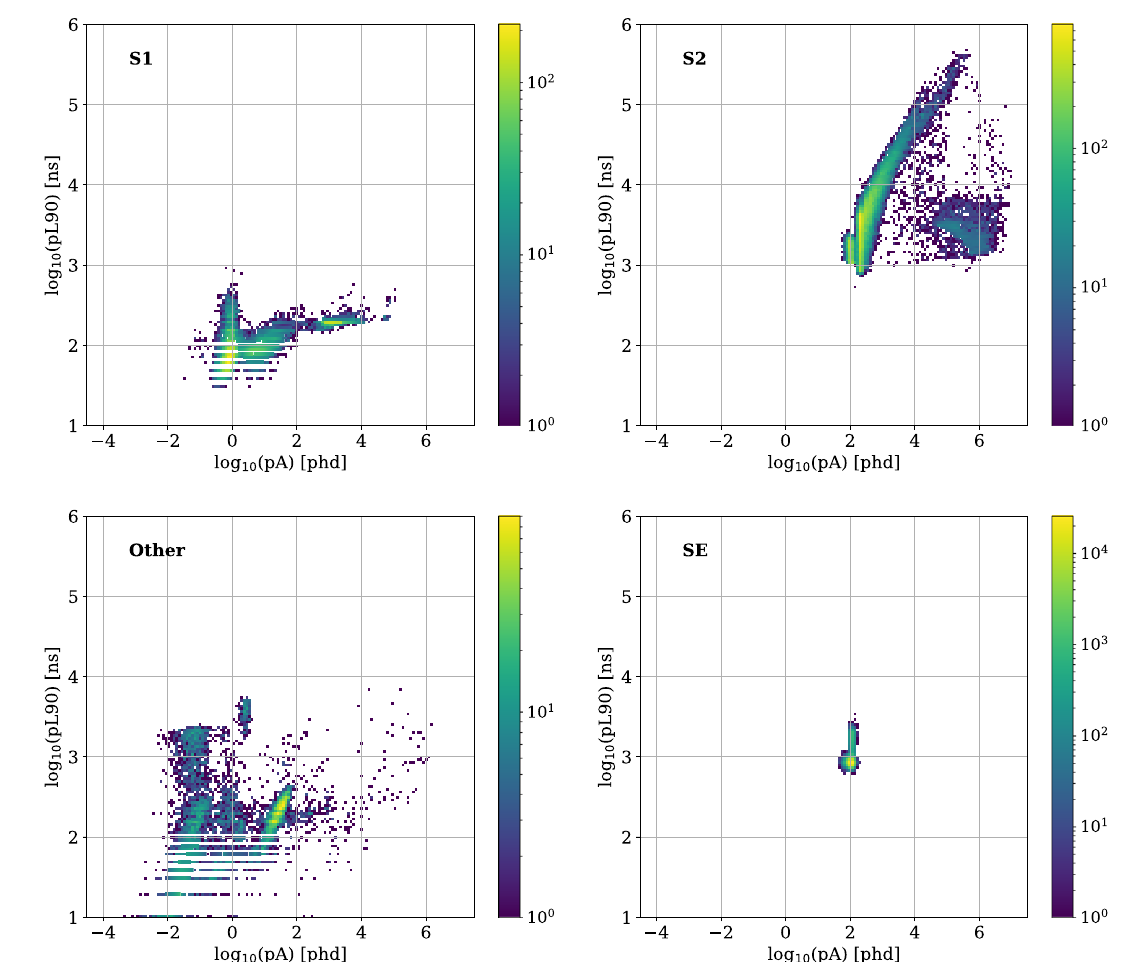
Fig. 5 Distribution of the pulse populations in the marginal distribu- tion pA vs pL90 after being processed by the RFClassifier. The top-left plotdisplaysthedistributionofpulsesclassifiedasS1.Thetoprightplot